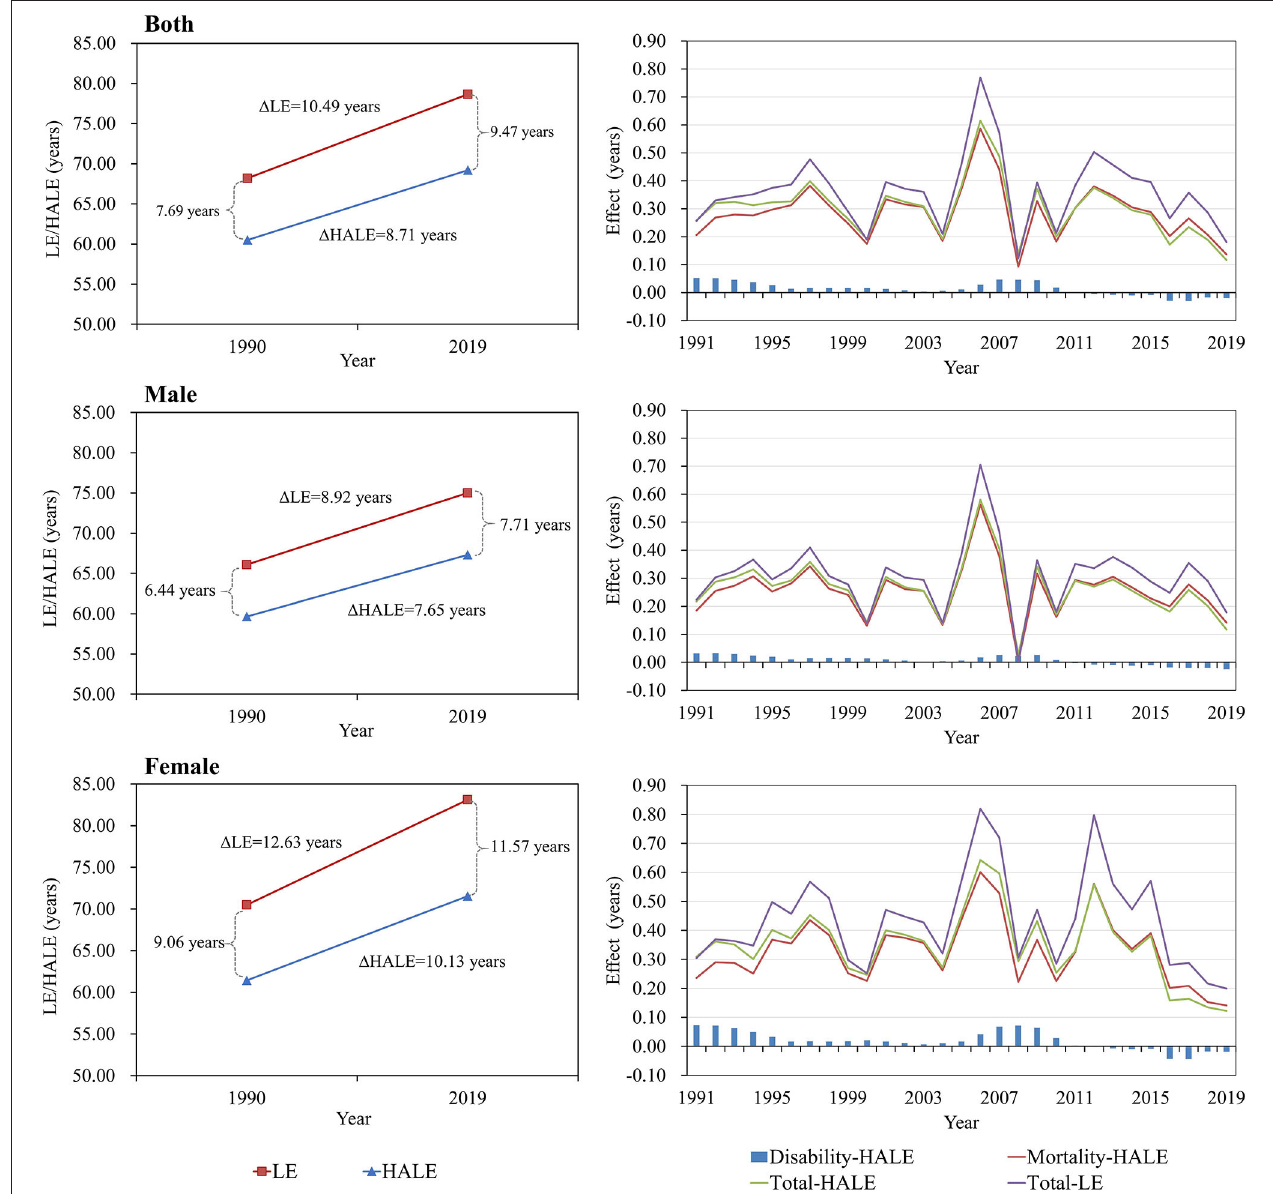
FIGURE 1 | Trends and effects of mortality and disability on changes in life expectancy (LE) and health-adjusted life expectancy (HALE) across year to year.